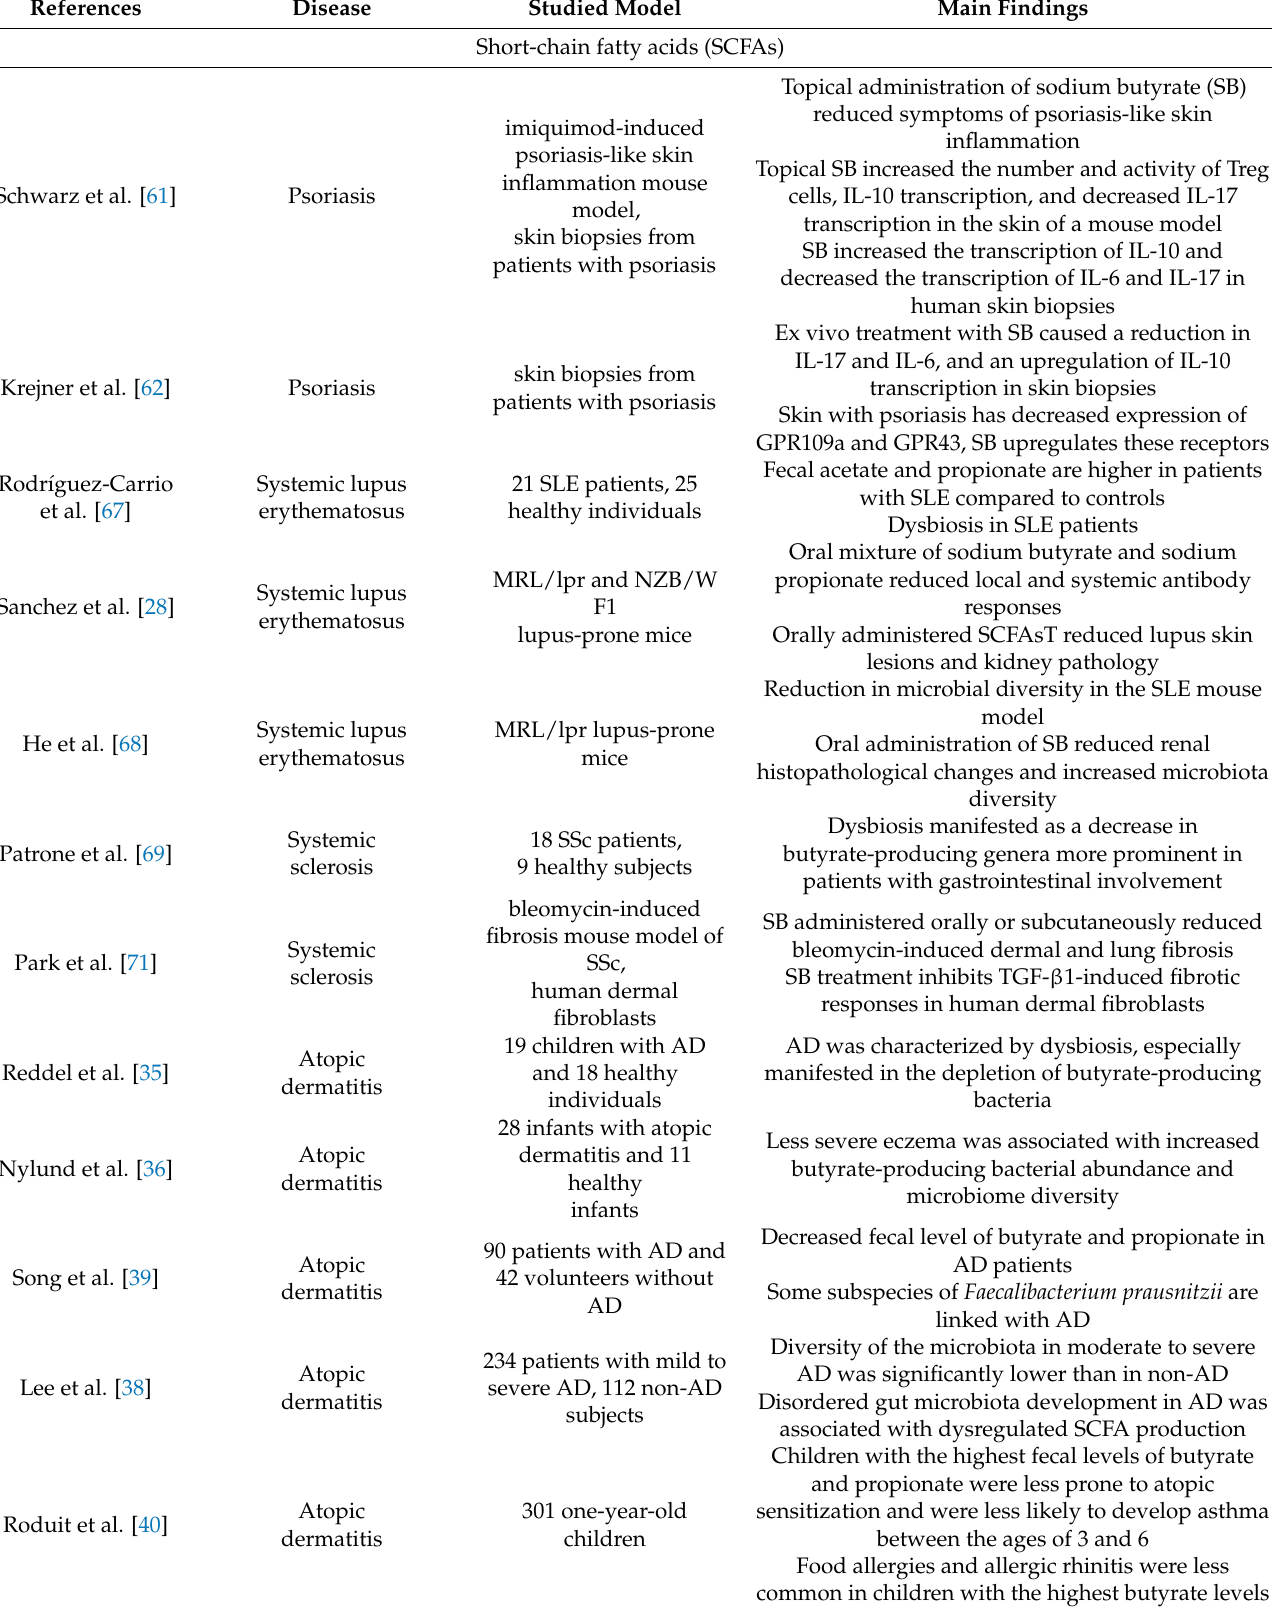
Table 1. A review of studies available on the subject of the impact of intestinal microbiota metabolites on dermatological